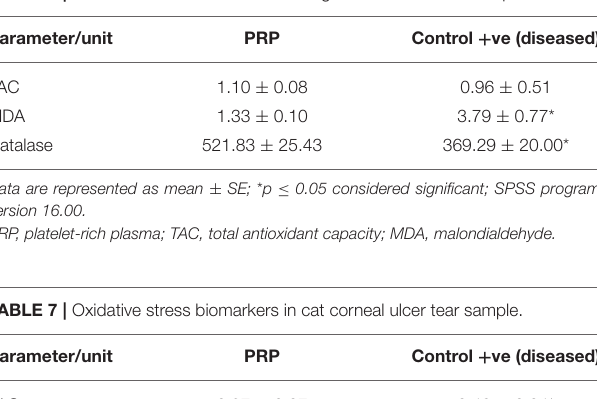
TABLE 6 | Oxidative stress biomarkers in dog corneal ulcer tear sample.